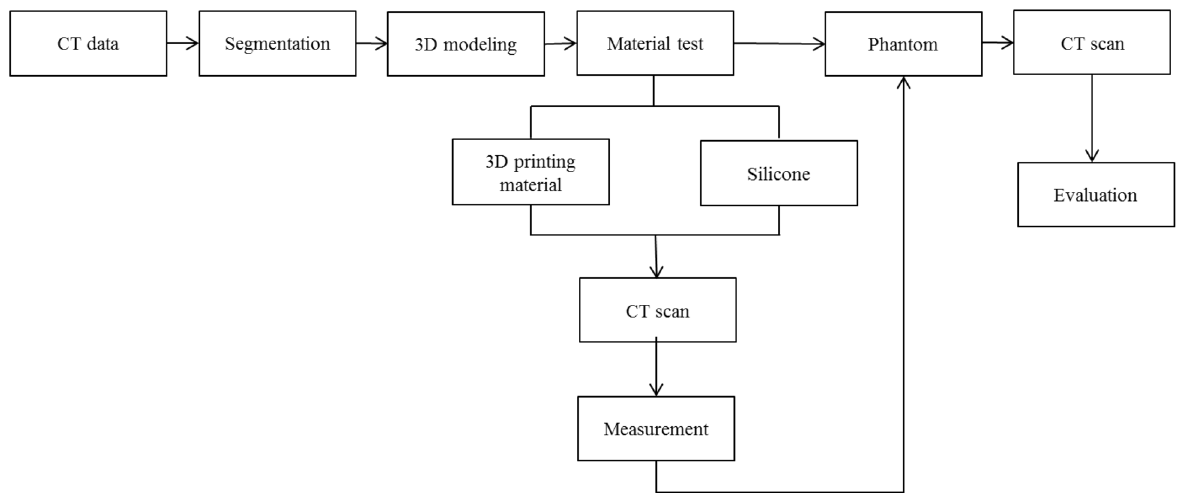
Figure 1. Overall workflow for fabricating a chest imaging phantom using three-dimensional printing and silicone